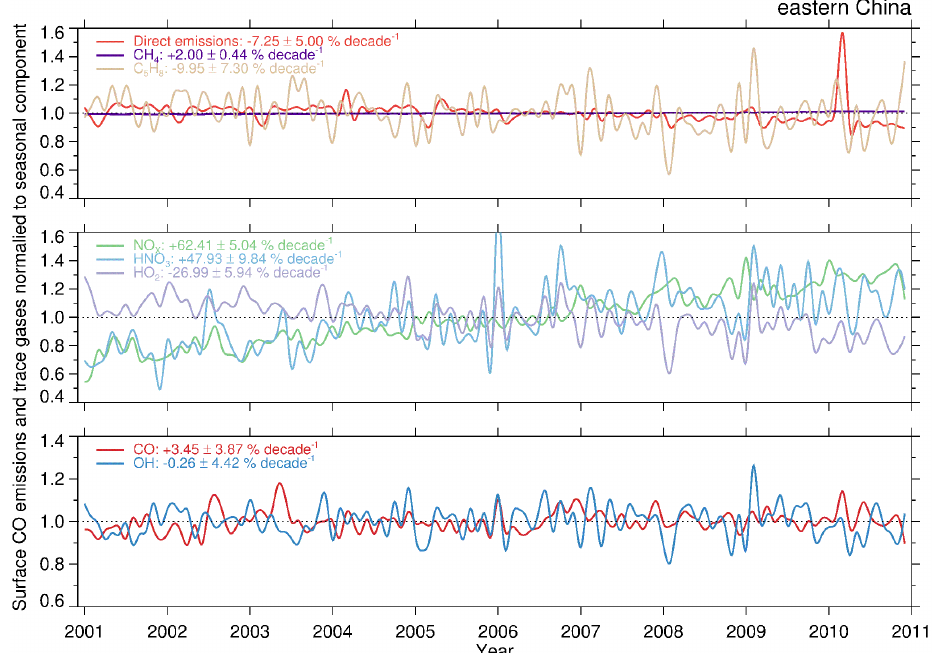
Figure 12. Long-term time series of surface CO emissions and relevant trace gases normalized to seasonal component over eastern China from 2001 to